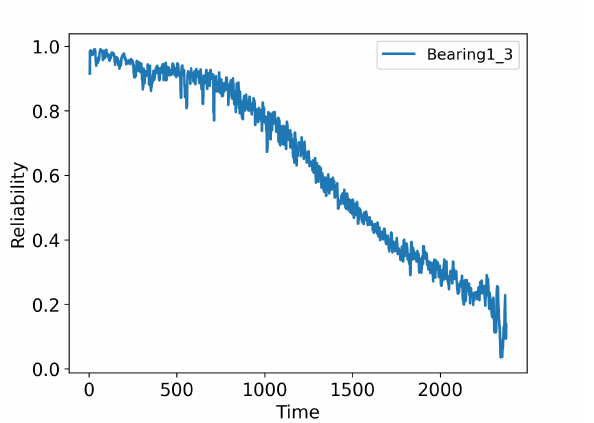
Figure 8. Degradation performance assessment of Bearing